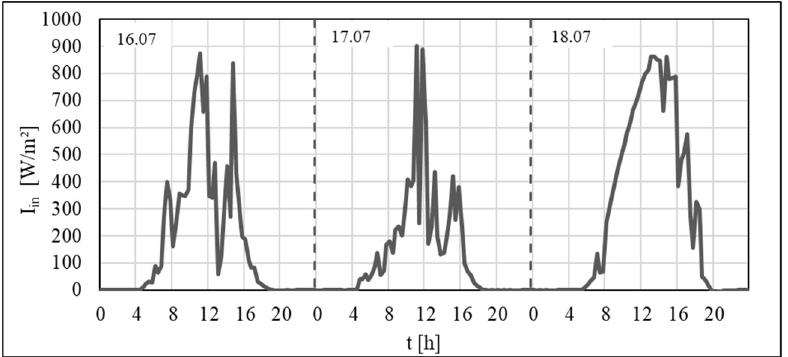
Figure 11. Changes of irradiance on days 16th to 18th of July.